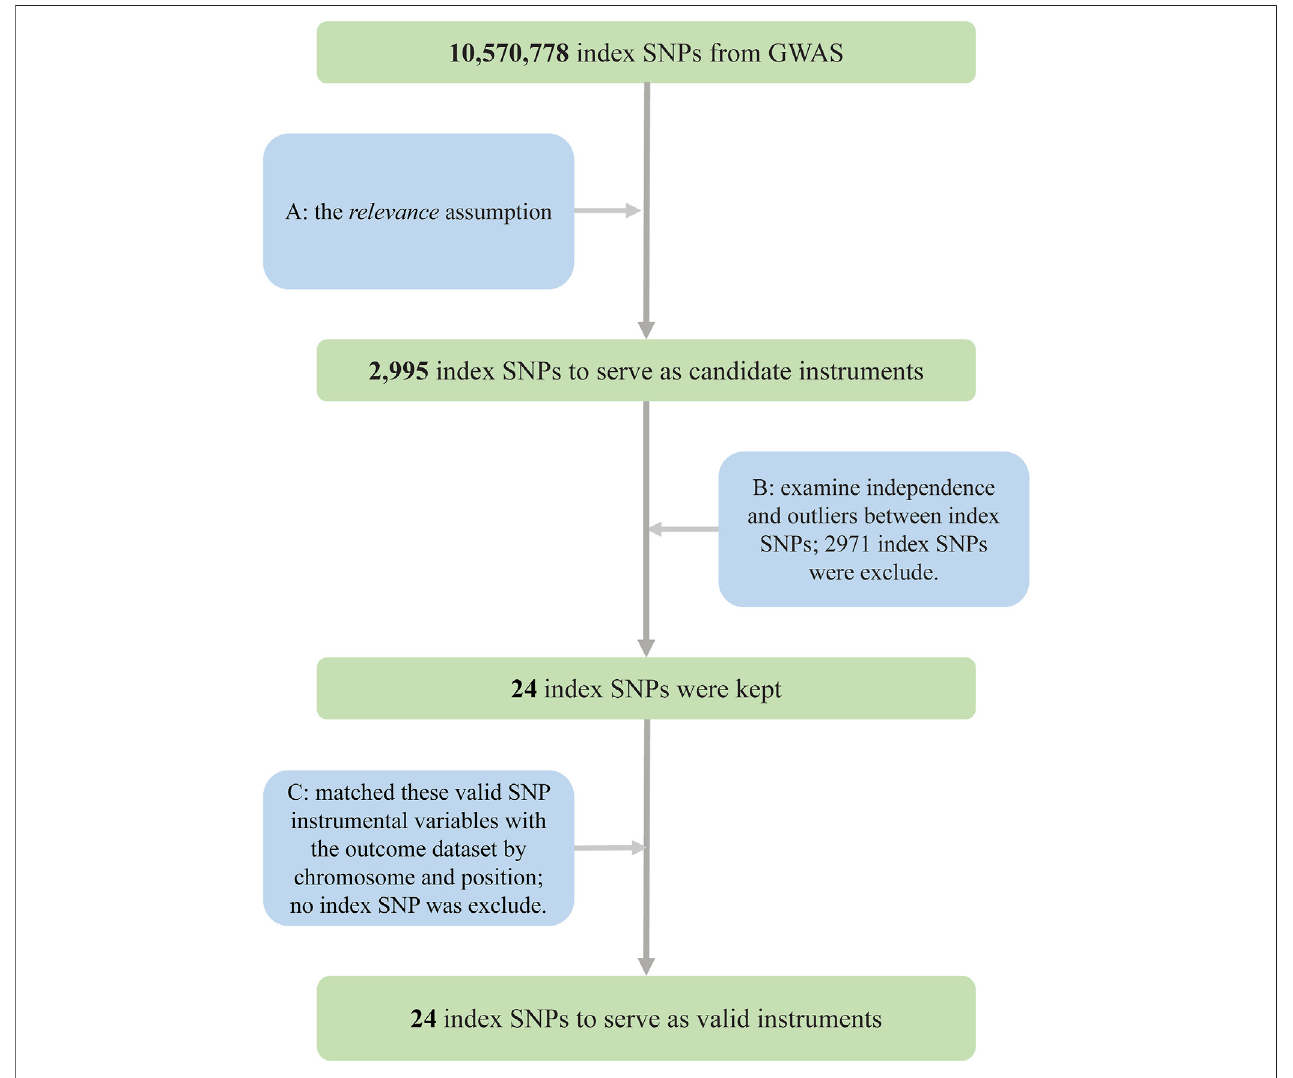
FIGURE2| FlowchartfortheselectionofinstrumentalvariablestoinvestigatethecausaleffectofteaintakeonT2D. (A) SelectedSNPssigni fi cantlyassociatedwith the exposure ( p = 5 × 10 − 8 , at genome-wide threshold). (B) Obtained independent SNPs and examined the effect size outliers with linkage disequilibrium (LD) with r 2 < 0.01 or the physical distance more than 10,000 kb. (C) Harmonized candidate SNPs with the outcome dataset by chromosome and position Abbreviations: GWAS, genome-wide association study; SNPs, single-nucleotide polymorphisms; T2D, type 2 diabetes.